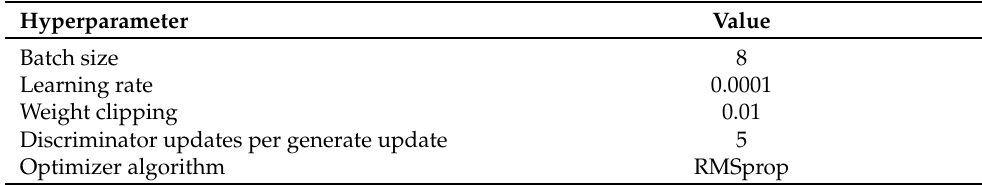
Table 3. Hyperparameters and values used for GAN in the proposed